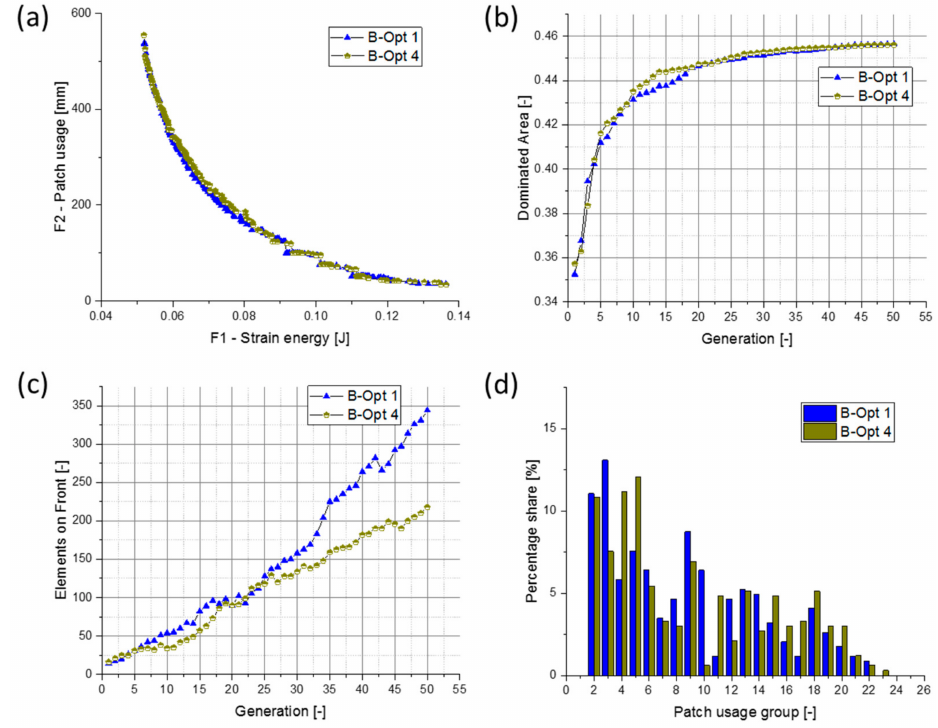
Figure 15. Comparison of the results for no-niching and niching (B-Opt 1: no-niching, B-Opt 4: niching): ( a – d ) as in Figure